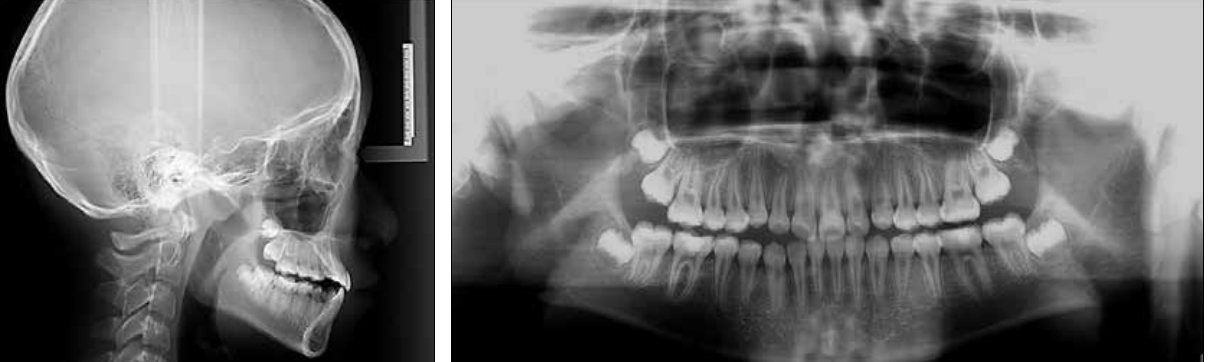
Figure 7. The radiographs after the first phase of